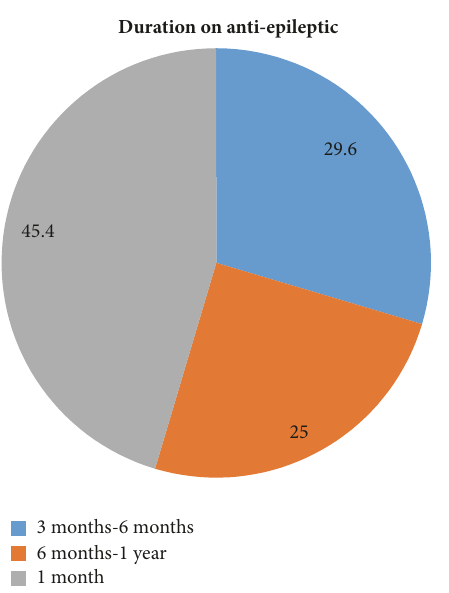
Figure1:Patient’sdurationonAEDsatDRH,Dessie,Ethiopia,from April to June